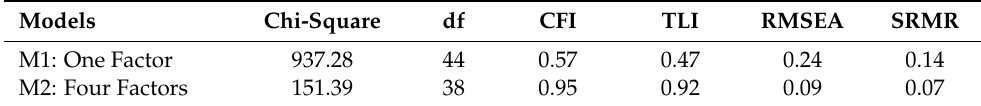
Table 4. Confirmative factor analysis of the measurement models.